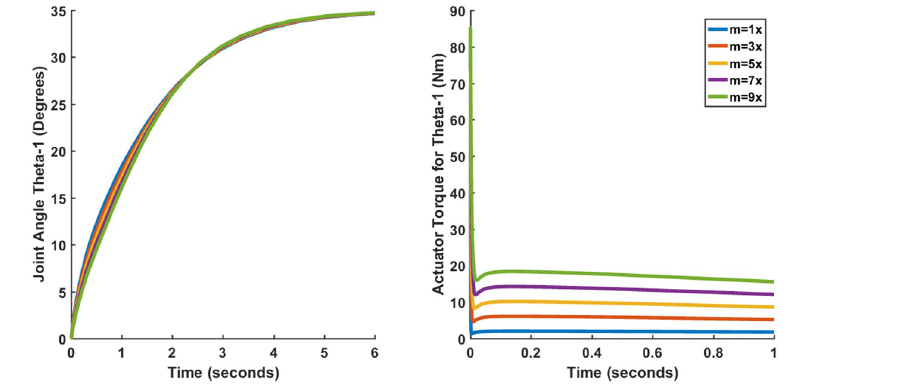
Fig 17. Performance of SFG-MIMO (Case I) under mass